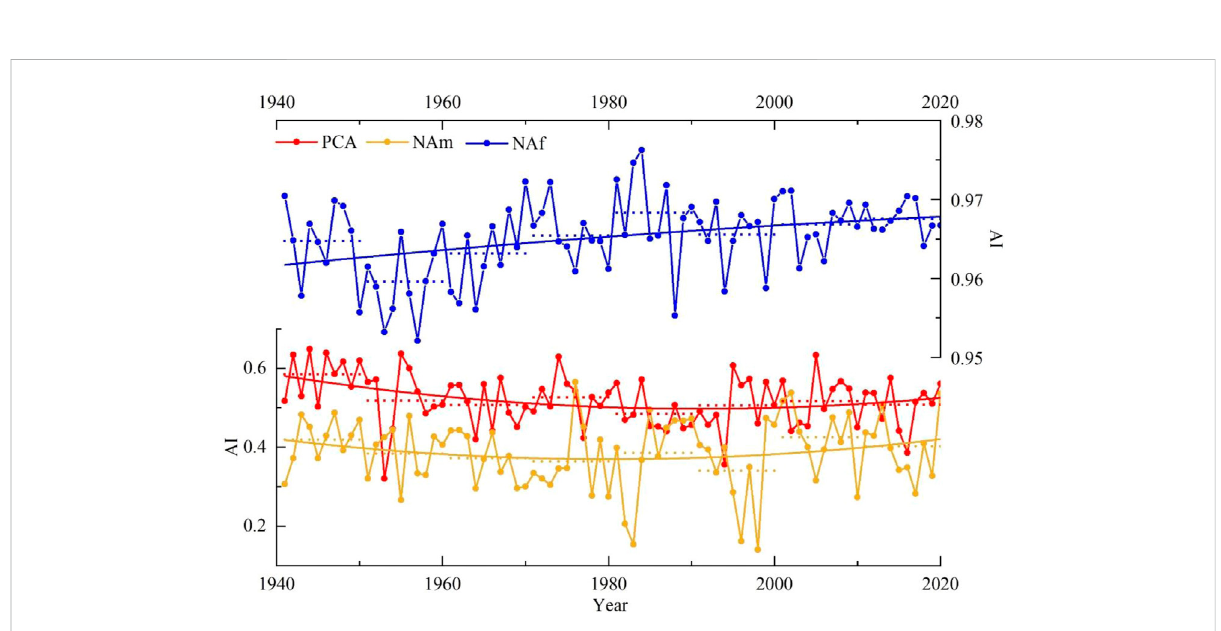
FIGURE 6 Interannual variationtrendsoftheAIinthreearidregionsfrom1941to2020.Thedottedlinespresentsthedecadalaverages,andthecurvesare the fi tting